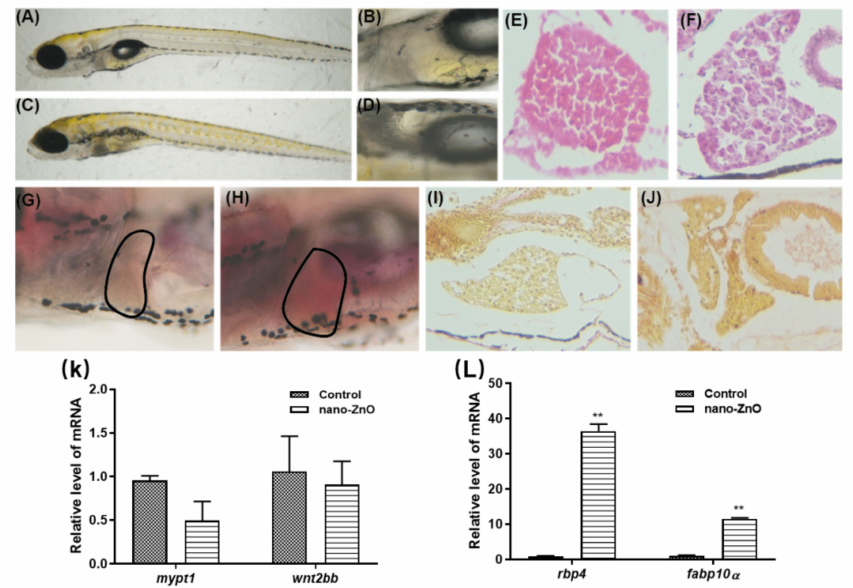
Figure 4. Hepatotoxic effects of 125 nmol/mL Nano-ZnO on zebrafish. Live observation of zebrafish liver differences between the control group and the Nano-ZnO treatment group: ( A ) control group (250 × ), ( B ) control group (410 × ), ( C ) Nano-ZnO treatment group (250 × ), ( D ) Nano-ZnO treatment group (410 × ). H&E staining of zebrafish liver: ( E ) control group (410 × ), ( F ) Nano-ZnO treatment group (410 × ). Oil red staining of zebrafish liver steatosis: ( G ) control group (410 × ), ( H ) Nano-ZnO treatment group (410 × ). Picric acid-Sirius scarlet staining of zebrafish liver steatosis: ( I ) control group (410 × ), ( J ) Nano-ZnO treatment group (410 × ). ( K ) Liver development-related genes relative level of mRNA. ( L ) Liver disease-related genes relative level of mRNA ** p <